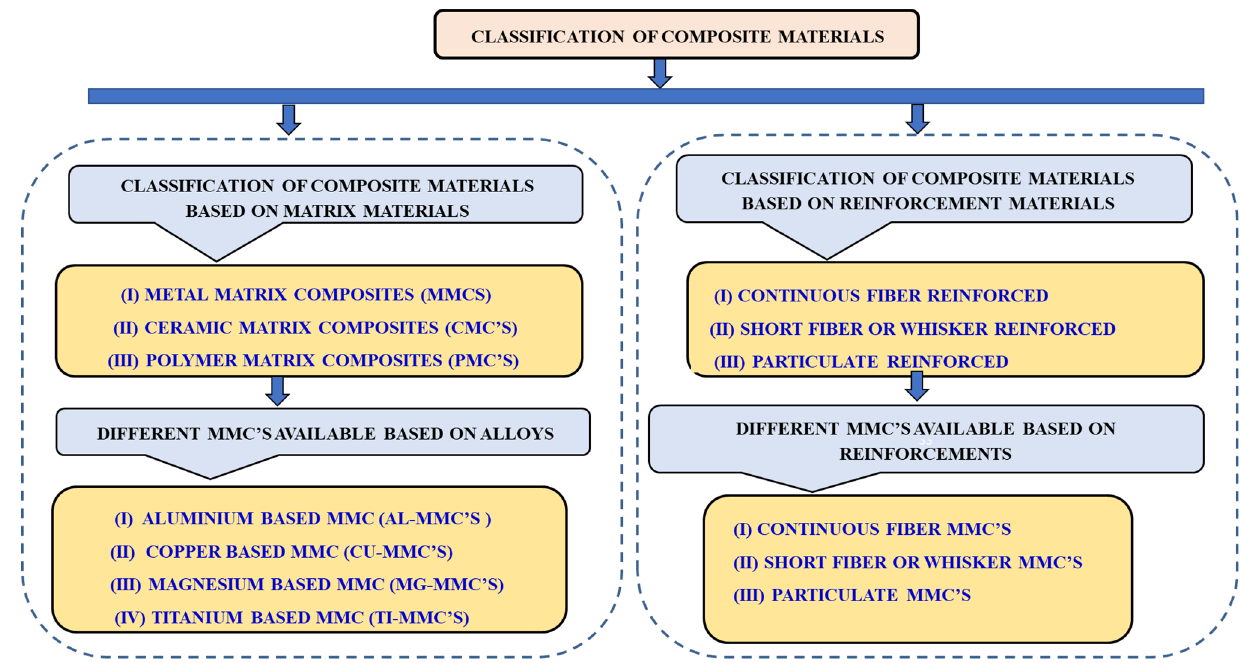
Figure 1. Flowchart showing the broad classification of composite materials .